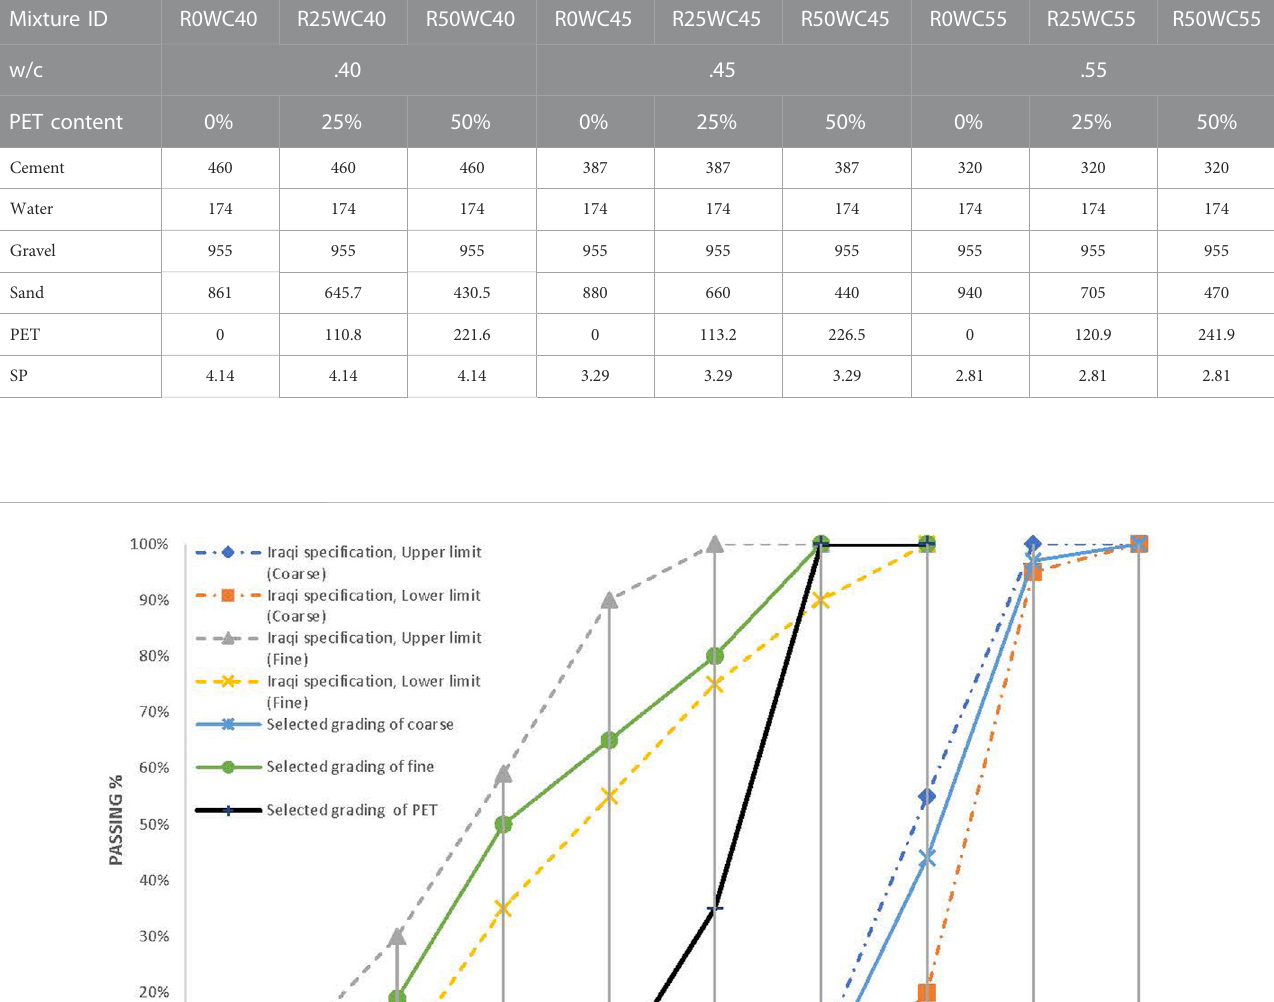
TABLE 5 Concrete mixture proportions (kg/m 3 ).